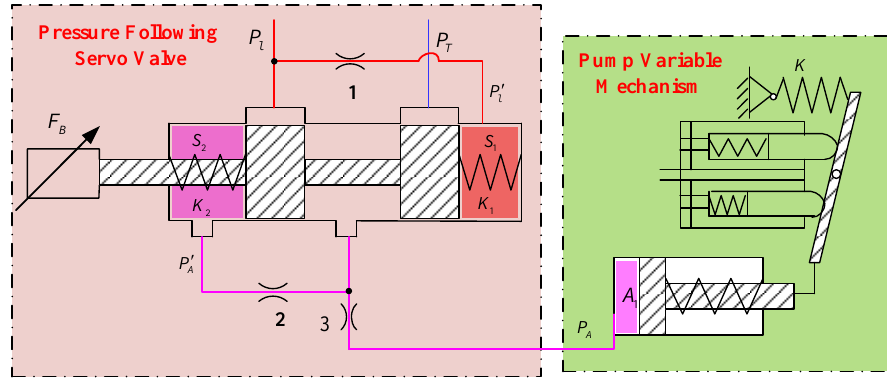
Figure 5. Schematic diagram of active load sensitive loop.